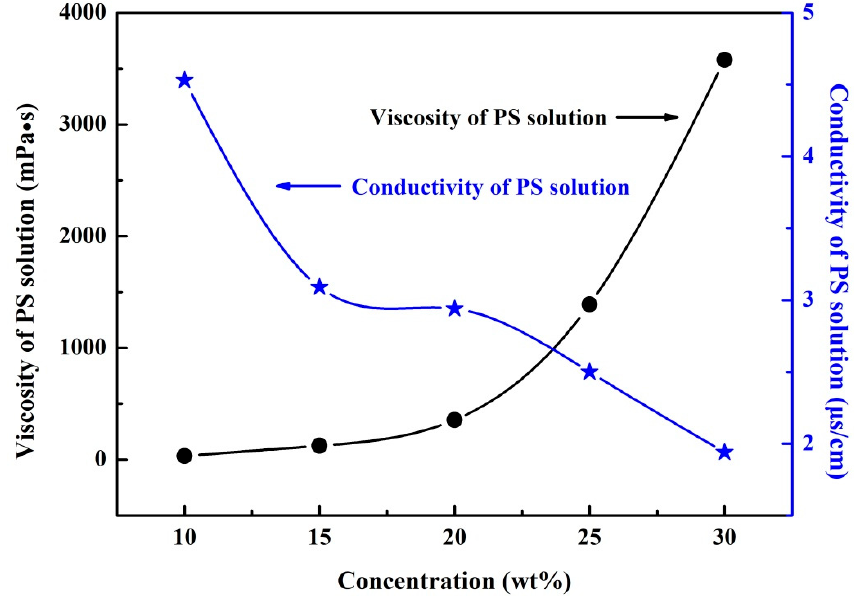
Figure 2. Viscosity and conductivity of polystyrene (PS) solutions as a function of concentration.